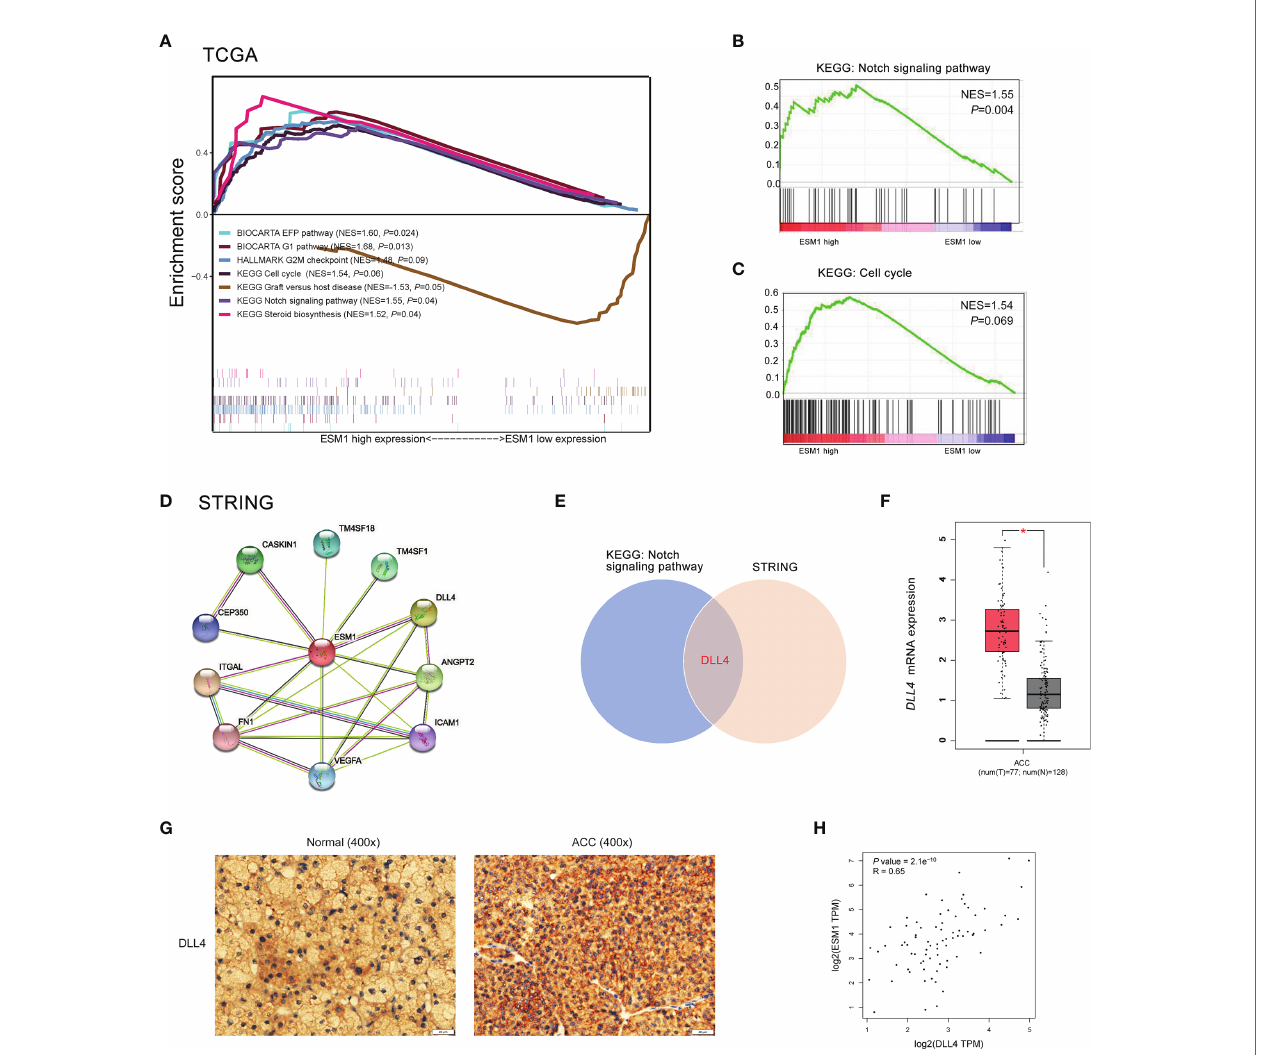
FIGURE 5 | The GSEA analysis of potential signaling pathway in ACC patients with ESM1 high versus ESM1 low . (A) The GSEA analysis of KEGG, Biocarta, Hallmark enrichment pathway in ACC patients with the NES and p -values of corresponding pathways. The Notch signaling pathway (B) and cell cycle (C) was signi fi cantly enriched in GSEA analyses. (D) The protein-protein interaction network of ESM1 and related proteins based on STRING platform. (E) Venn diagram of Notch signaling pathway and STRING analyses. DLL4 expression based on GEPIA platform (F) and IHC of human samples (G) . (H) The correlation between the expression of ESM1 and DLL4 in ACC. * p <